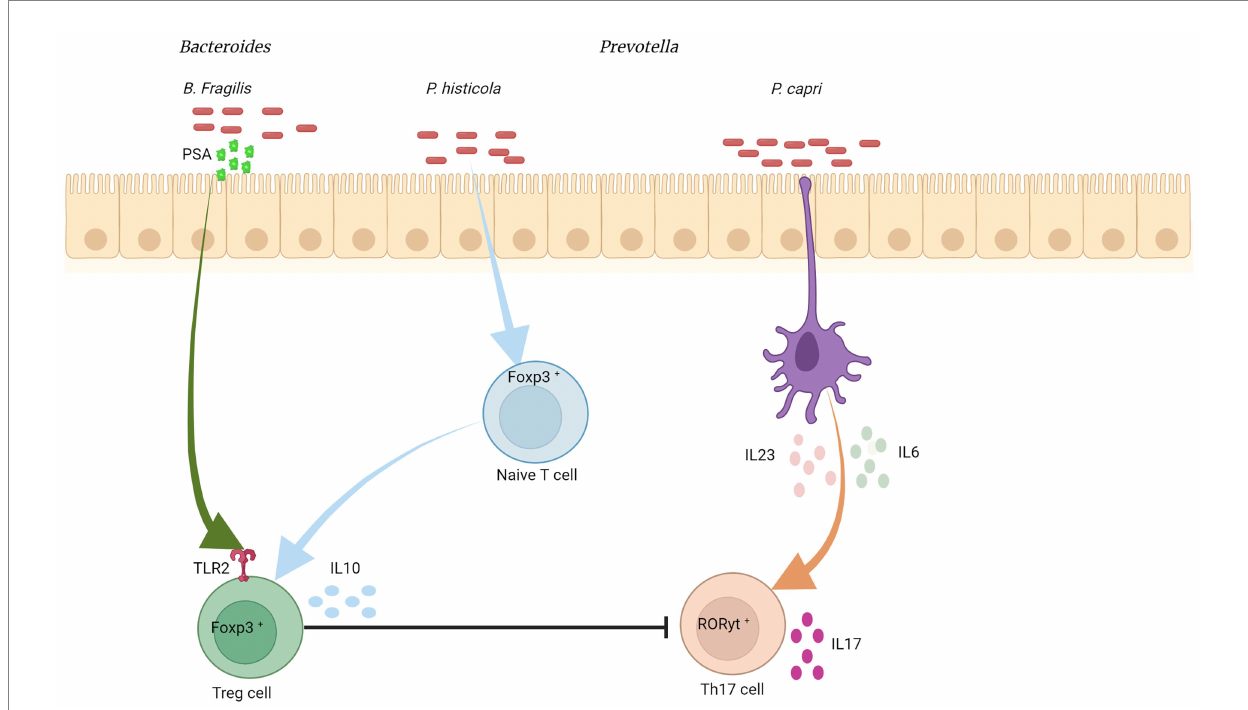
FIGURE 2 Bacteroides/Prevotella colonization and cytokine modulation. Bacteroides fragilis was associated with the induction of an anti-inflammatory response, inducing the differentiation of CD4+ T cells into Treg cells, which produce IL-10 and suppress Th17. This differentiation into Treg is mediated by TLR2 (from CD4+ cells), which recognizes polysaccharide A (from the bacterial outer membrane), activating a signaling cascade. Prevotella copri stimulates dendritic cells to express high levels of IL-6 and IL-23, which may increase the number of intestinal Th17 cells. P. histicola suppresses serum levels of pro-inflammatory cytokines such as IL-2, IL-17, and TNF- α , by increasing Treg cells in the gut and reducing Th17 cell responses. Created with Biorender.com.